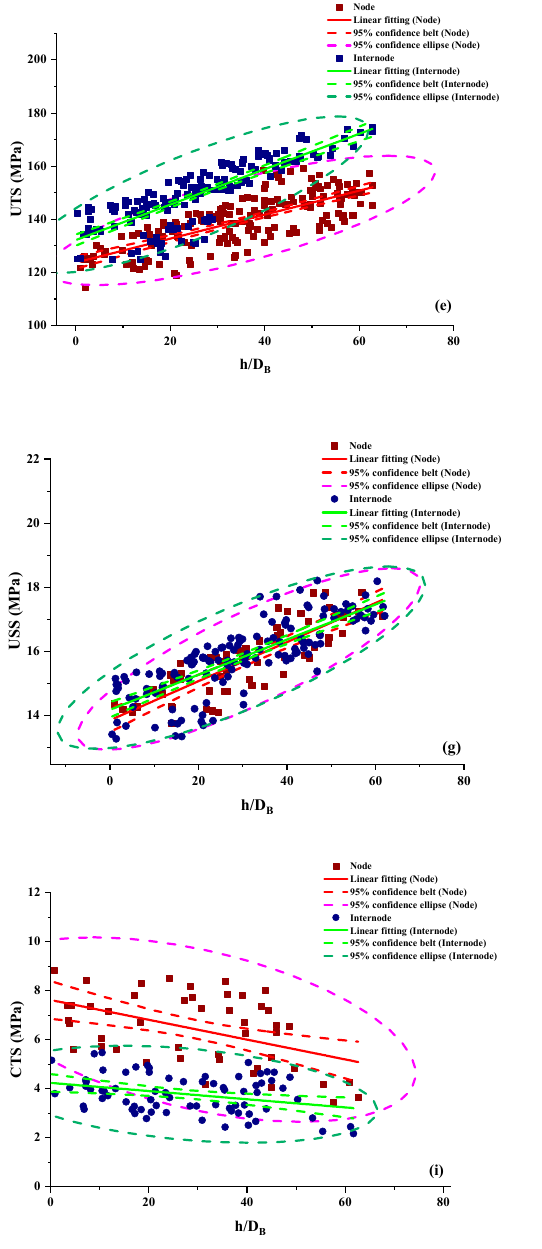
Figure 8. Fitting curve of mechanical properties and standardized parameters: ( a ) UCS; ( b ) UCE; ( c ) MOR; ( d ) MOE; ( e ) UTS; ( f ) UTE; ( g ) USS; ( h ) CCS; ( i ) CTS. Table 3. Relationship between the physical and mechanical properties and h/D B. The Fitting Parameters